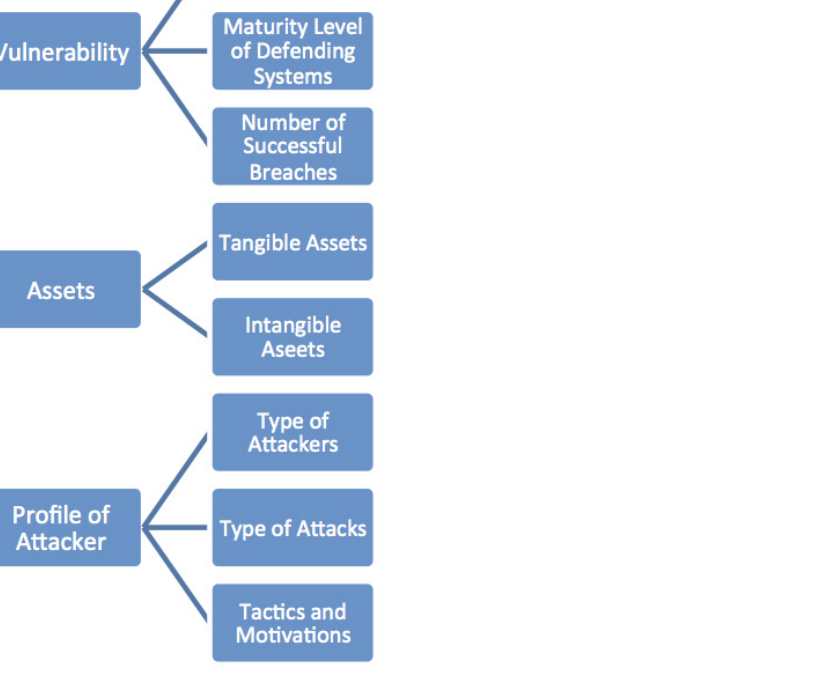
Figure 1. Cyber Value at Risk Components. Source: World Economic Forum, “Partnering for Cyber Resilience: Towards the Quantification of Cyber